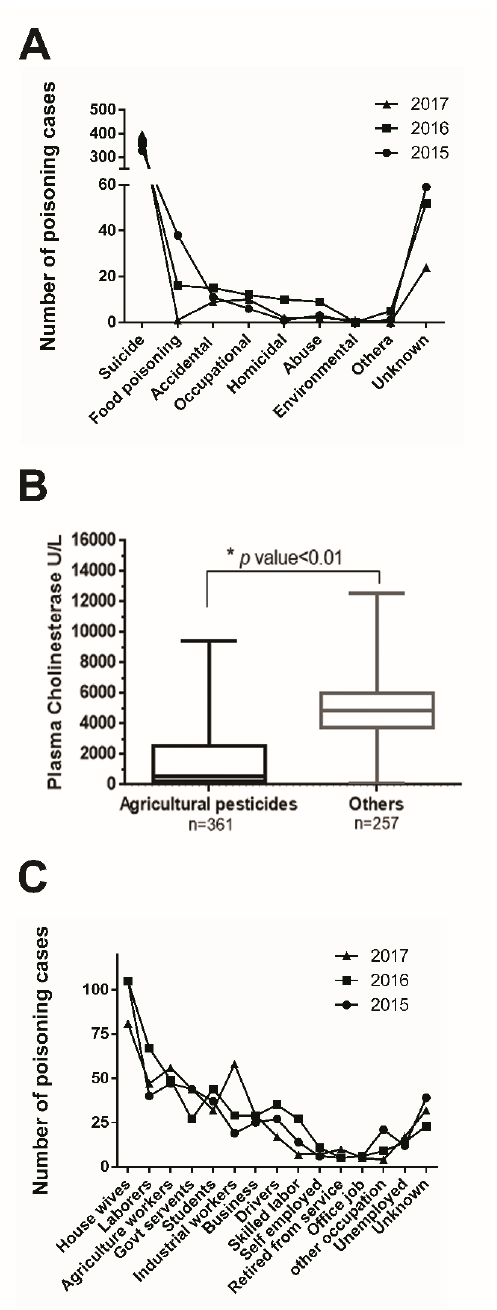
Figure 3. The trend of poisoning 2015-2017 in relation to the circumstances of poisoning (A), the box plot showing plasma cholinesterase activity in victims of poisoning due to agricultural pesticides in comparison to other known causes (B), and the occupation of patients